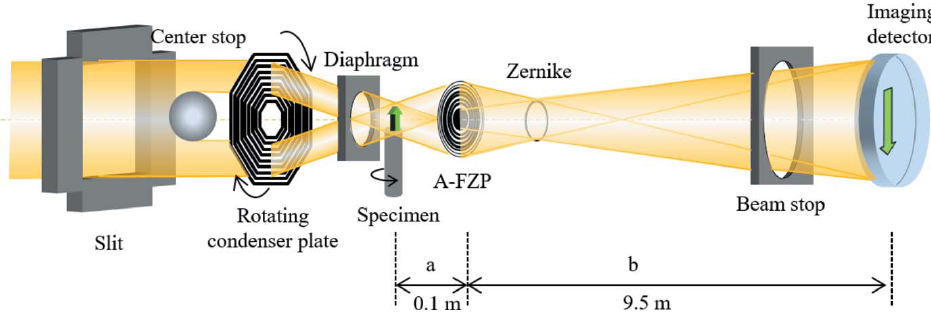
Figure 1 Schematic diagram of the Zernike phase-contrast X-ray microscopy optical system with pseudo-Ko¨hler illumination constructed at SPring-8